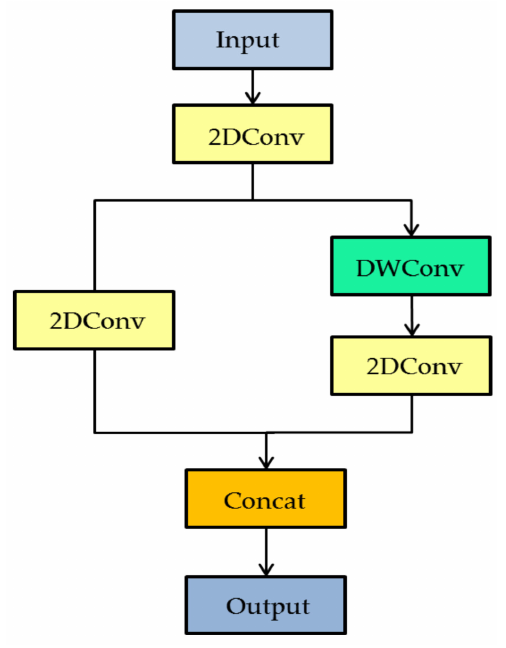
Figure 3. Improved ghost